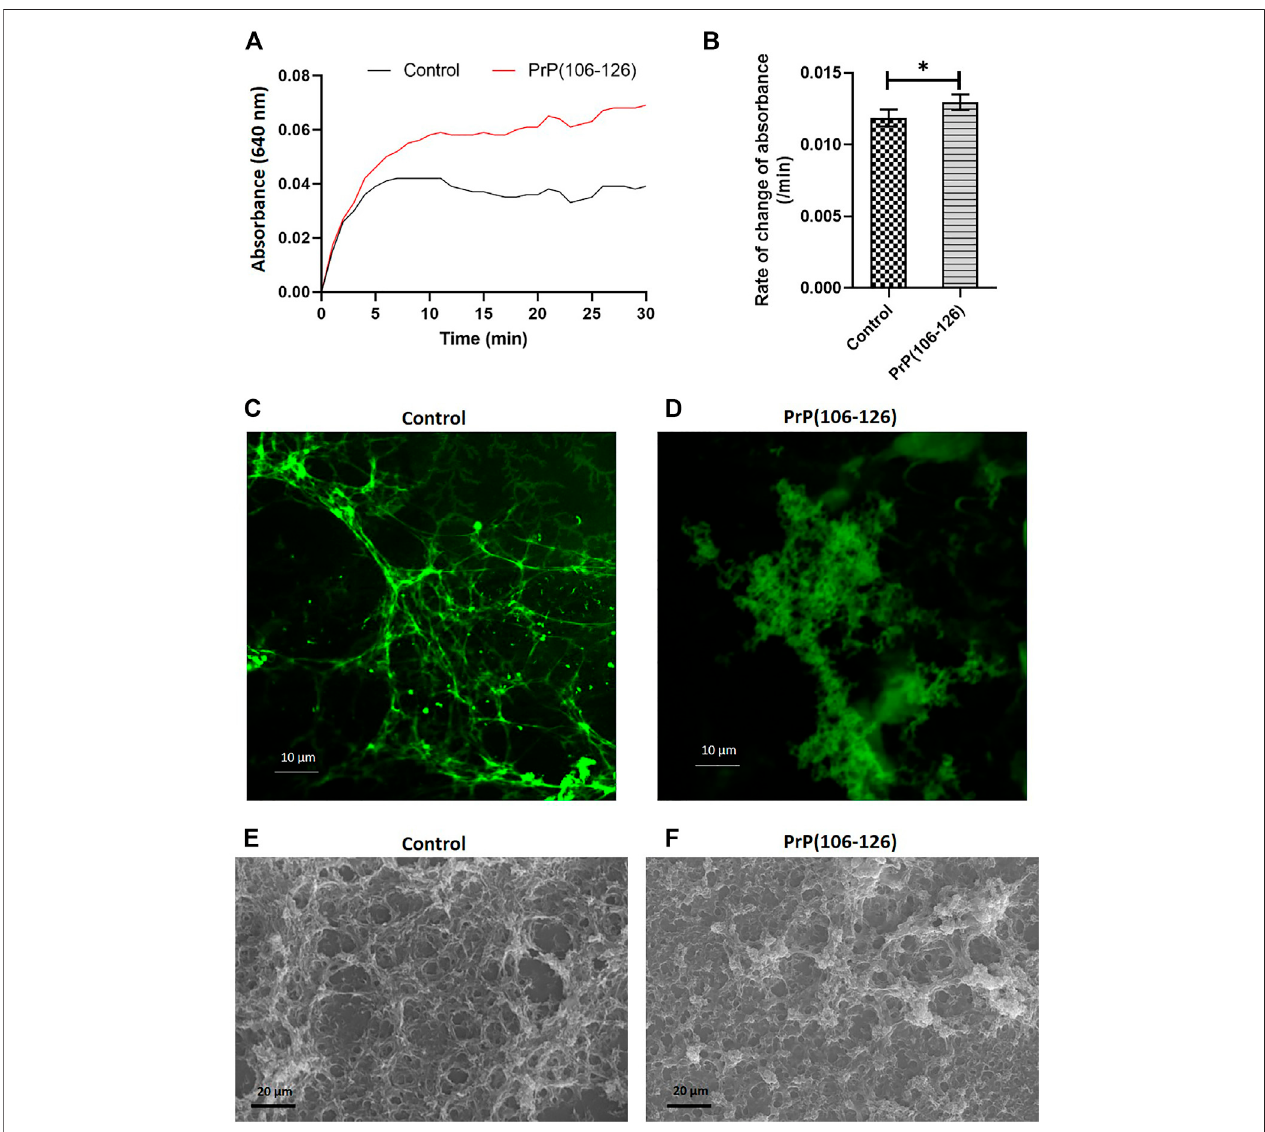
FIGURE 5 | PrP(106 – 126) augments fi brin clot formation and alters clot structure. (A) Clot formation was induced by addition of thrombin to fi brinogen in the presence or absence of PrP. Turbidity of the clot was recorded as the change in absorbance at 640 nm at 5 min intervals. (B) Corresponding bar diagram representing rate of change of absorbance per minute (calculated by subtracting fi nal absorbance value from the initial value and dividing by total duration, 30 min). (C) and (D) Confocalmicroscopyimages of fl uorescent fi brinclotsformed intheabsence (C) orpresence (D) ofPrP. (E) and (F) Scanningelectron microscopyimagesof fi brin clot formed in the absence (E) or presence (F) of PrP. Figures are representative of ≥ 3 independent experiments (mean ± SEM, p < 0.05).